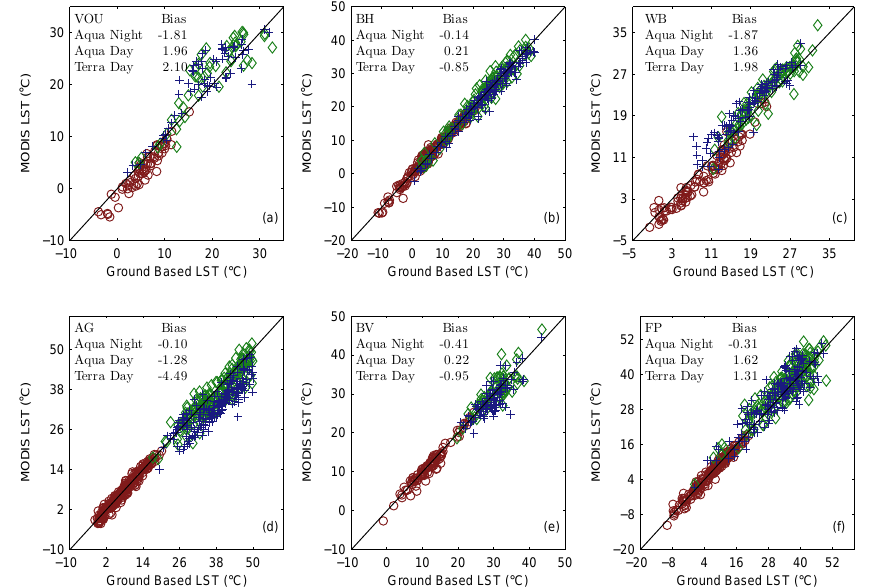
Fig. 6. Comparison of ground measured LST with night-time Aqua LST (circles), daytime Aqua LST (diamonds) and daytime Terra LST (crosses) at mixed cropland (VOU, a ), coniferous forest (BH, b ), deciduous forest (WB, c ), semi-arid grassland (AG, d ), maize/soybean cropland (BV, e ) and temperate grassland (FP, f ). Bias (MODIS LST – ground LST) is noted in ◦ C.